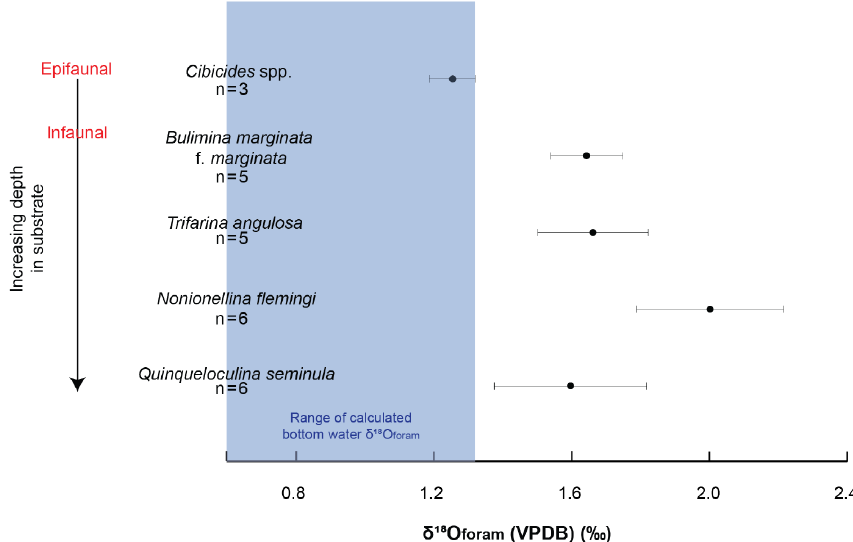
Figure 5. Deviation of benthic foraminiferal oxygen isotopic composition ( δ 18 O foram ) from calculated equilibrium according to Marchitto et al. (2014) ( δ 18 O foram − δ 18 O w (VSMOW) + 0.27) = − 0 . 225 T + 3 . 50) for five species from Hanfield and Norman inlets. This equation, derived for Cibicides spp., is indistinguishable from the temperature equation from Kim and O’Neil (1997) for inorganic calcite, so is considered valid for all species. Range of expected δ 18 O foram encompasses the entire range of measured summer fjord bottom water temperatures and δ 18 O w from Hanfield and Norman inlets (Tables 2 and